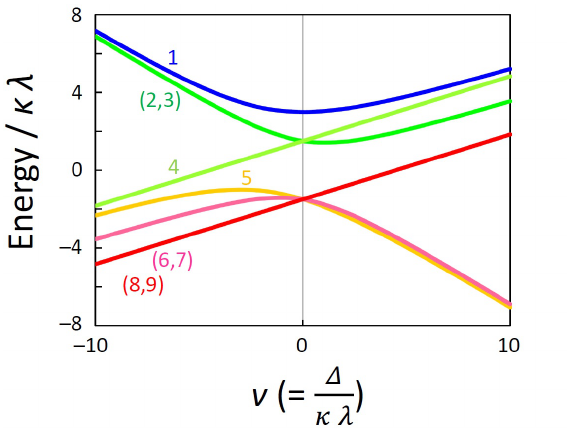
Figure 1. Energy diagram of the nine states of the 3 T 1 ( g ) term ( λ = 100 cm − 1 , κ =